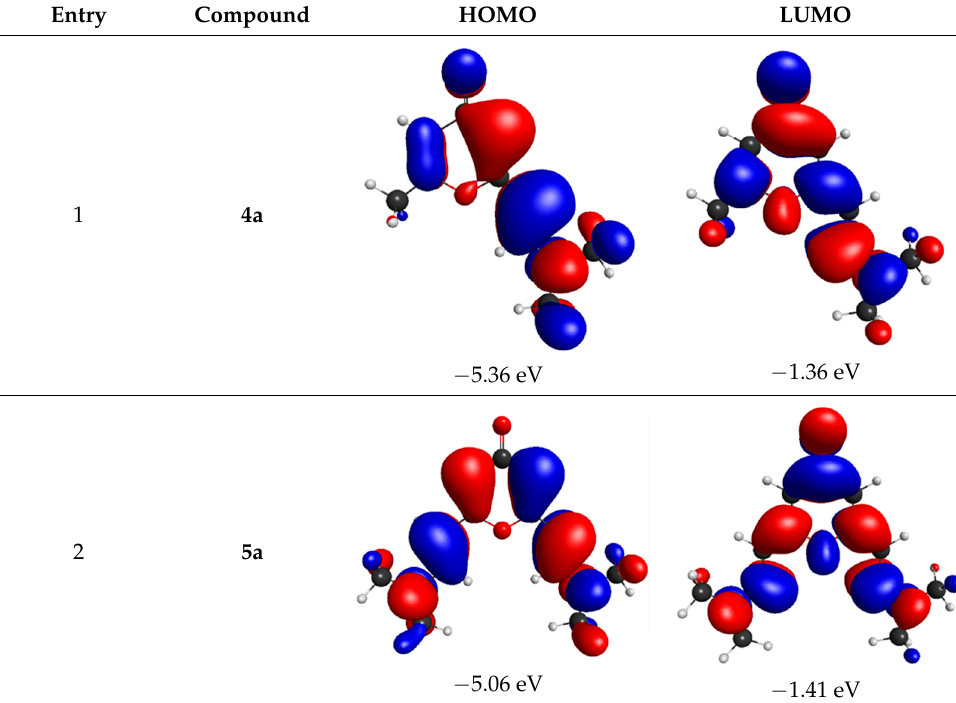
Table 8. Ground state frontier orbitals of compounds 4a and 5a in MeOH a . Entry Compound